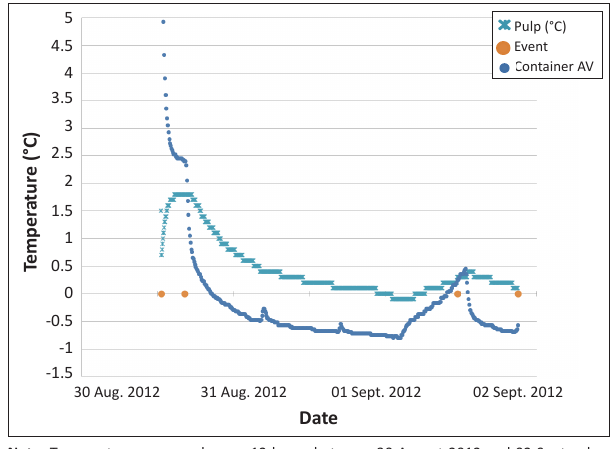
FIGURE 4: Comparison of average ambient temperature and fruit pulp temperature for apples.